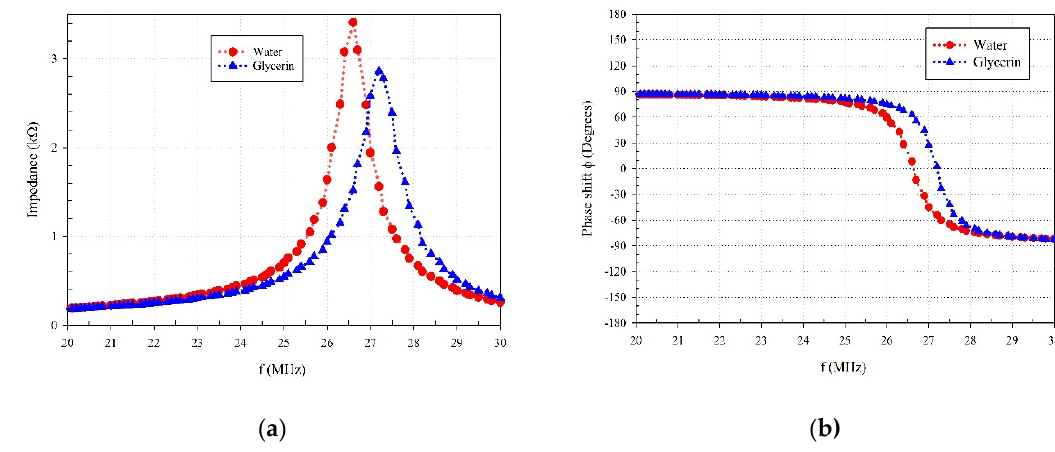
Figure 7. Measured (a) impedance of the probe in a fluid, and (b) the phase shift in a fluid.